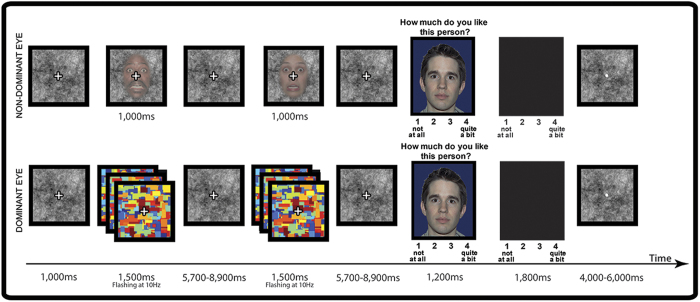
Schematic representation of the experimental trial structure.Negative (fearful faces) and neutral (flowers) stimuli were shown for 1 sec in a blocked fashion. Conscious awareness of these stimuli was manipulated within-subjects. In stimulus-unaware blocks, the presentation of high-contrast, flashing Mondrian patterns to participants’ dominant eye precluded the visibility of stimuli shown to their non-dominant eye. In aware blocks, stimuli were presented to both dominant and non-dominant eyes, and were thus fully visible. Participants were asked to rate the likeability of novel neutral faces using their immediate first impression, thereby providing an index of affective coloring. (Note that this image is not covered by the Creative Commons Attribution license—photographs are from the NimStim Face Stimulus Set. Development of the MacBrain Face Stimulus Set was overseen by Nim Tottenham and supported by the John D. and Catherine T. MacArthur Foundation Research Network on Early Experience and Brain Development. (http://www.macbrain.org/resources.htm).